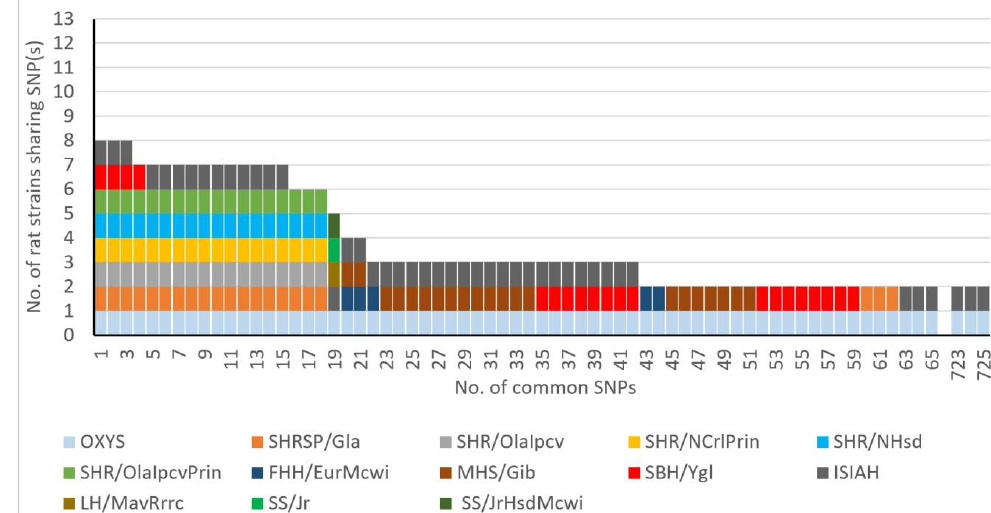
Figure 3. Numbers of common SNPs between OXYS rats and hypertensive rat strains. The colors correspond to the SNPs that were identified in one of the strains of hypertensive rats being analyzed.